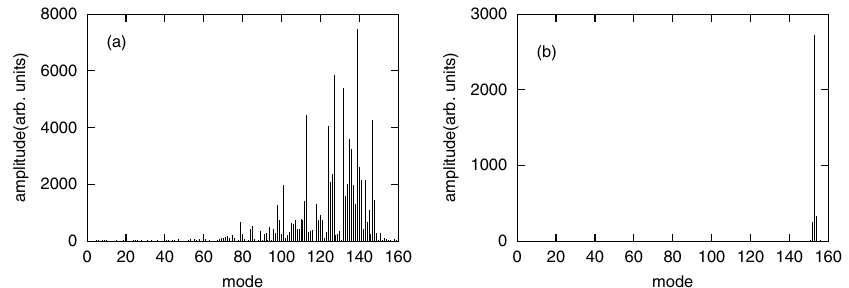
FIG. 6. Sideband of the oscillation simulated at a beam energy of 1.3 GeV. (a) and (b) are for positron and electron beams,